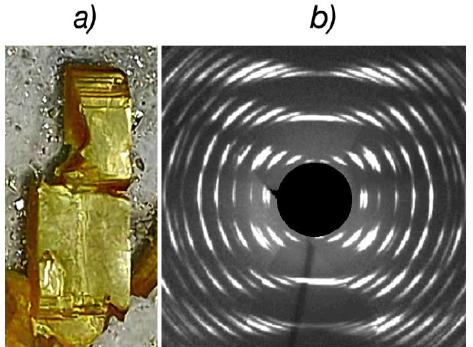
Figure 3. Crystal image ( a ) and XRD pattern ( b ) of the intercalated In 1.2 Ga 0.8 S 3 ·0.5(p-AP) crystals.